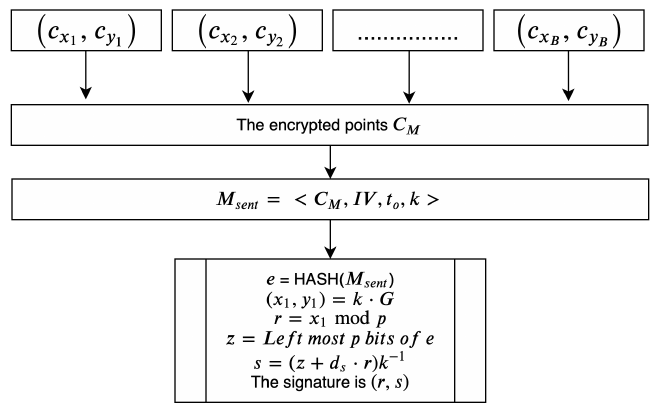
Figure 14. Sender ensures message integrity by signing it with d s .